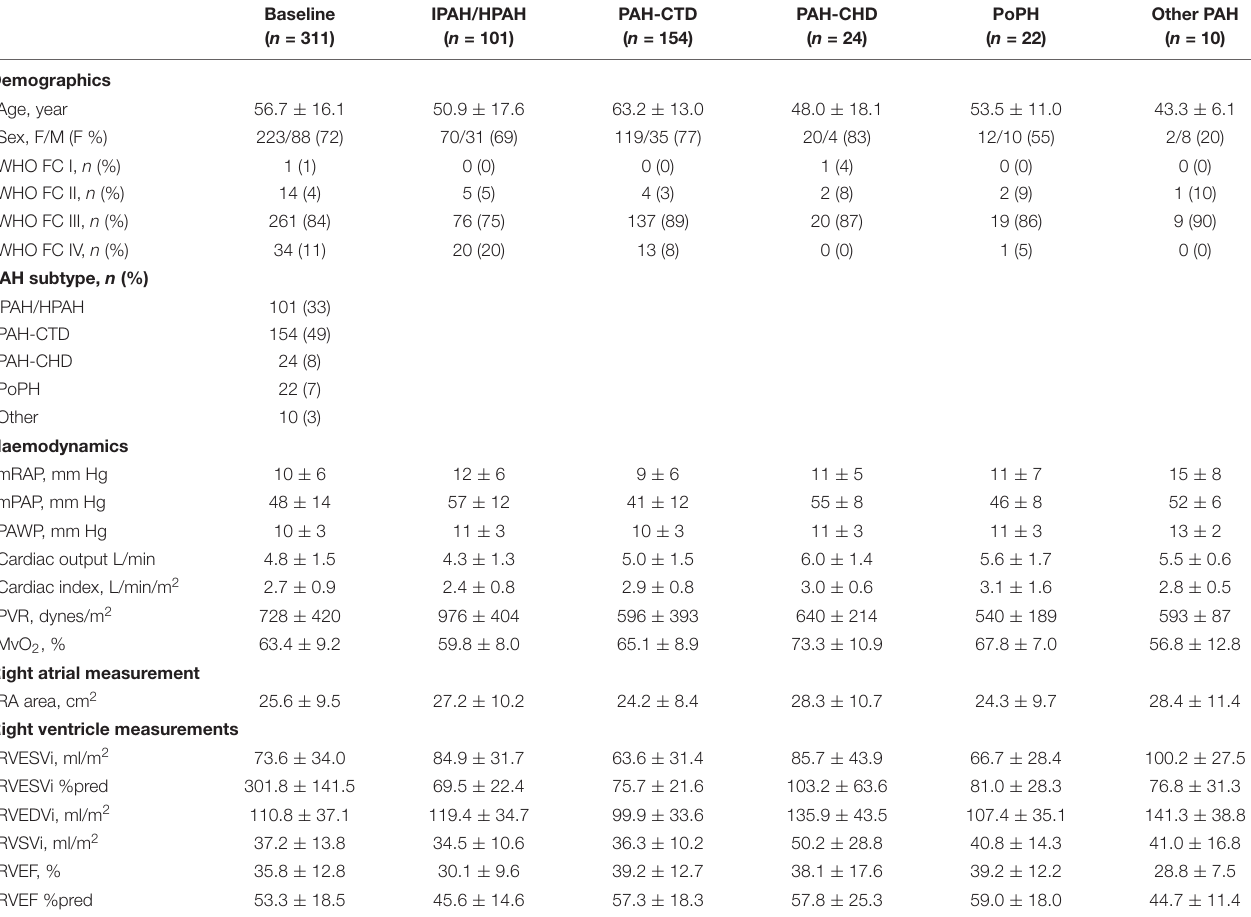
TABLE 1 | Baseline demographics, haemodynamics, and cardiac MRI